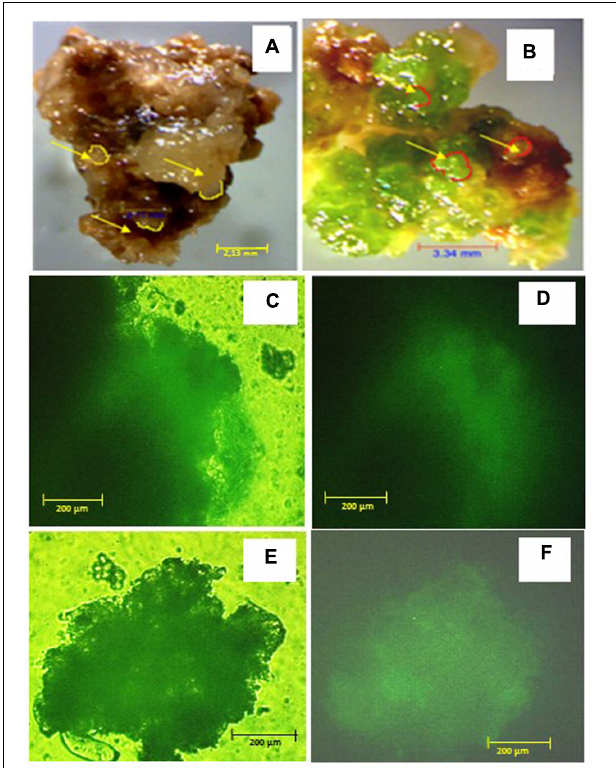
FIGURE 2 | Callus phenotype and viability after 6 months on 10% w/v PEG and control media: (A) control callus; (B) PEG-selected callus, arrows indicate somatic embryos; viability of control callus after FDA staining observed under transmission (C) or UV (D) light; viability of PEG-selected callus after FDA staining observed under transmission (E) or UV (F) light. Scale bars are A = 2.13 mm, B = 3.34 mm; and C–F = 200 µ m.